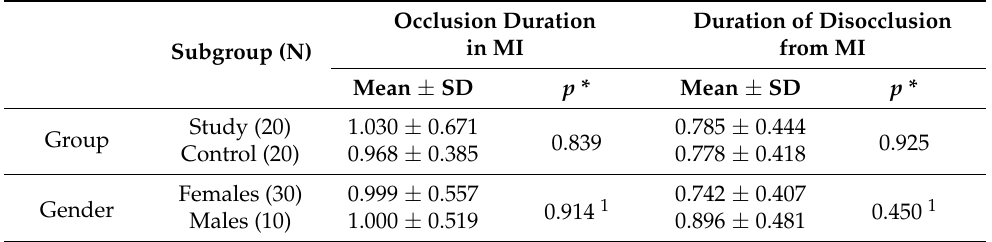
Table 4. Duration of occlusion and disocclusion from the MI position by group (seconds). Occlusion Duration in Subgroup (N)